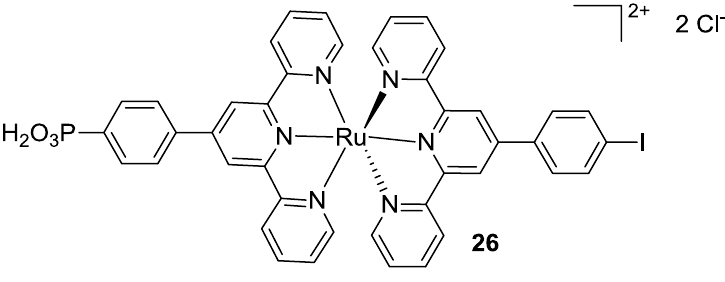
Figure 20. Bis-tpy complex proposed by Stergiopoulos et al. [106].